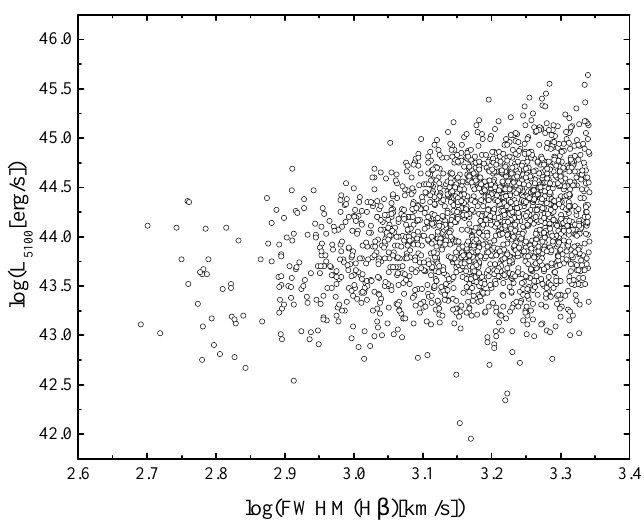
Figure 4. The dependence of FWHM (H β ) on the luminosity at 5100 Å L 5100 from the initial